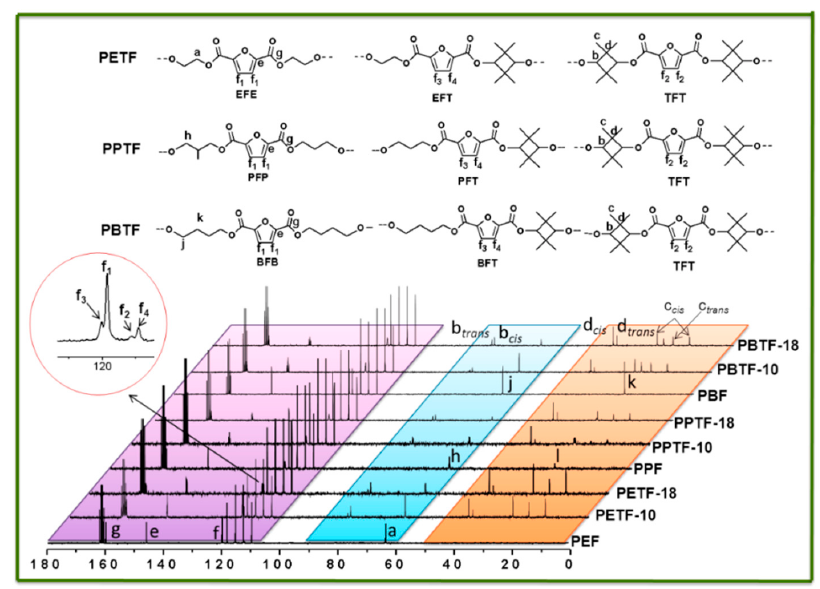
Figure 2. The 13 C NMR spectra of PEF, PPF, PBF, and the copolyesters modified with CBDO.